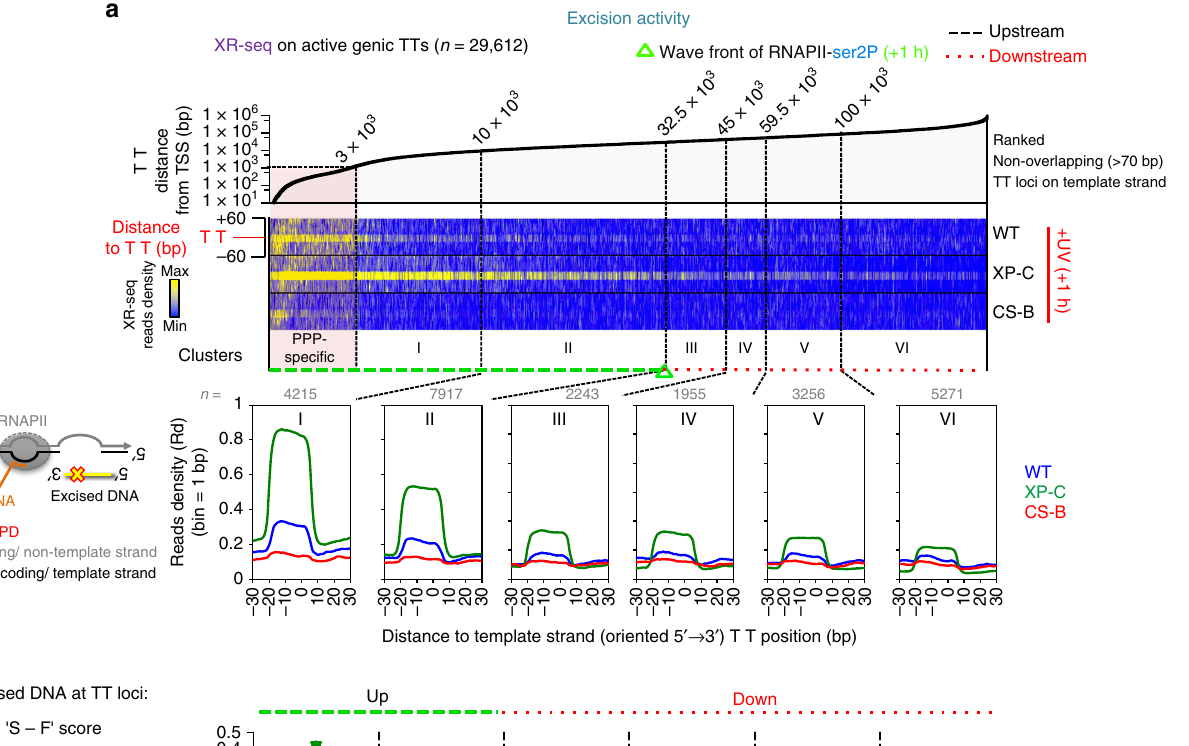
Excised DNA at TT loci: